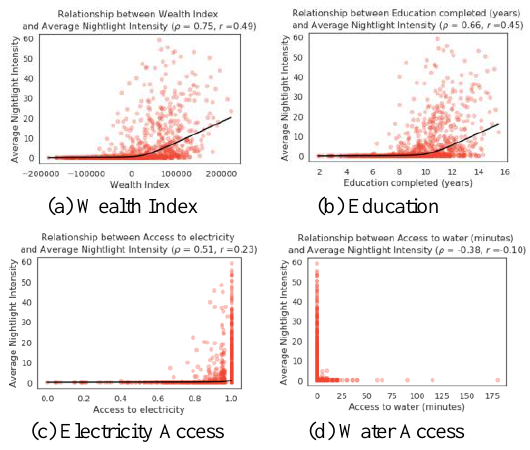
Figure 1. Relationship between average nighttime light luminosity and the Philippine socioeconomic indicators (wealth index, education completed, access to electricity, access to water) at the cluster level. Black line indicates a LOESS curve fitted to the